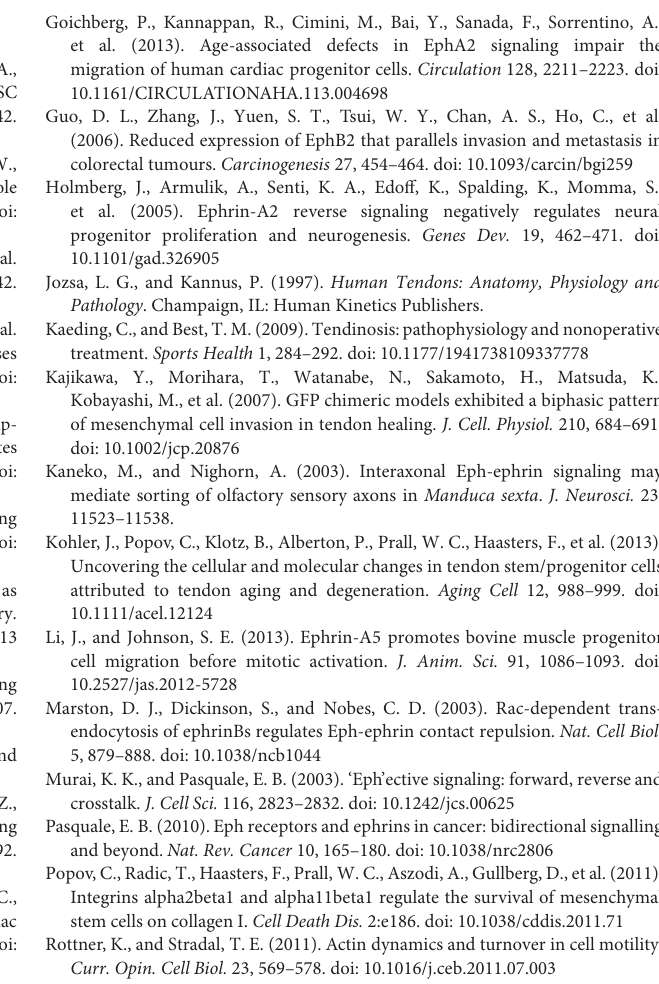
FIGURE S1 | Complete western blot image. Aliquots of equal amounts of protein from three Y-TSPC and A-TSPC treated with EphA4-, EphB2-, EphB4-, and EFNB1-Fc proteins were loaded onto the same western blot membranes, which were first probed for the expression levels of phospho-FAK, ERK, AKT, Jnk, and p38. Next, the same membranes were stripped and probed for the corresponding total-FAK, ERK, AKT, Jnk, and p38. Comparable protein loading was validated with anti-GAPDH antibody. Complete western blot image corresponding to the phosphor-lanes in the inset B of Figure 2 . The same procedure was performed for another two A-TSPC donors. Abbreviations: MW – positions of the molecular weight protein standard; 1–3, different Y-TSPC